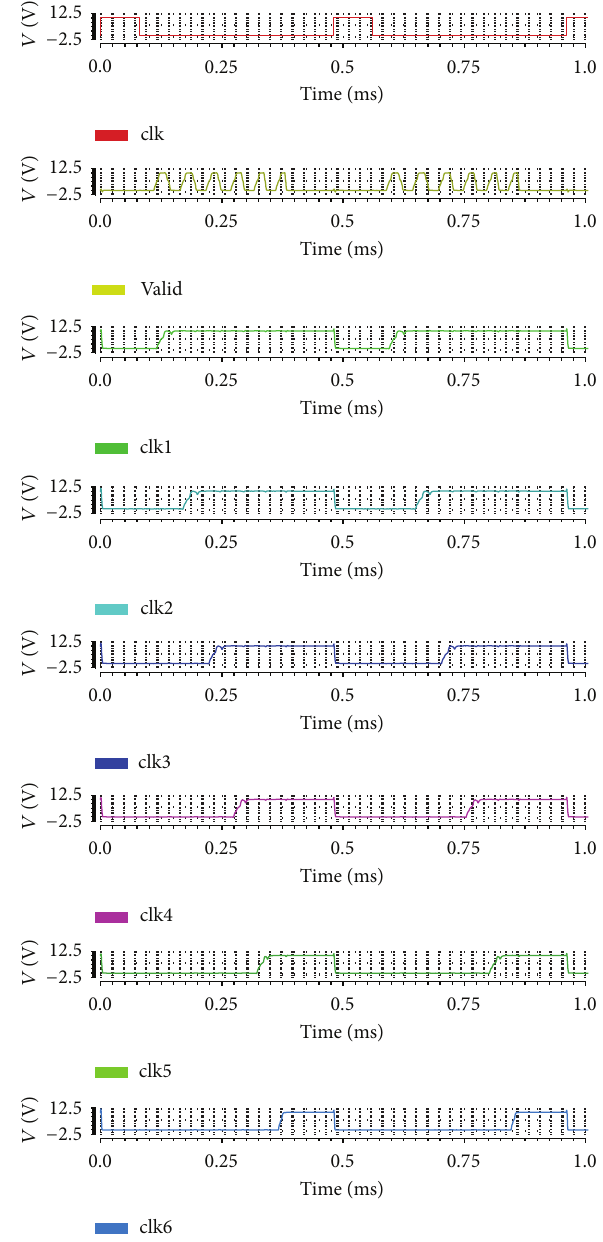
Figure 14: Timing diagram made from SAR logic outputs.